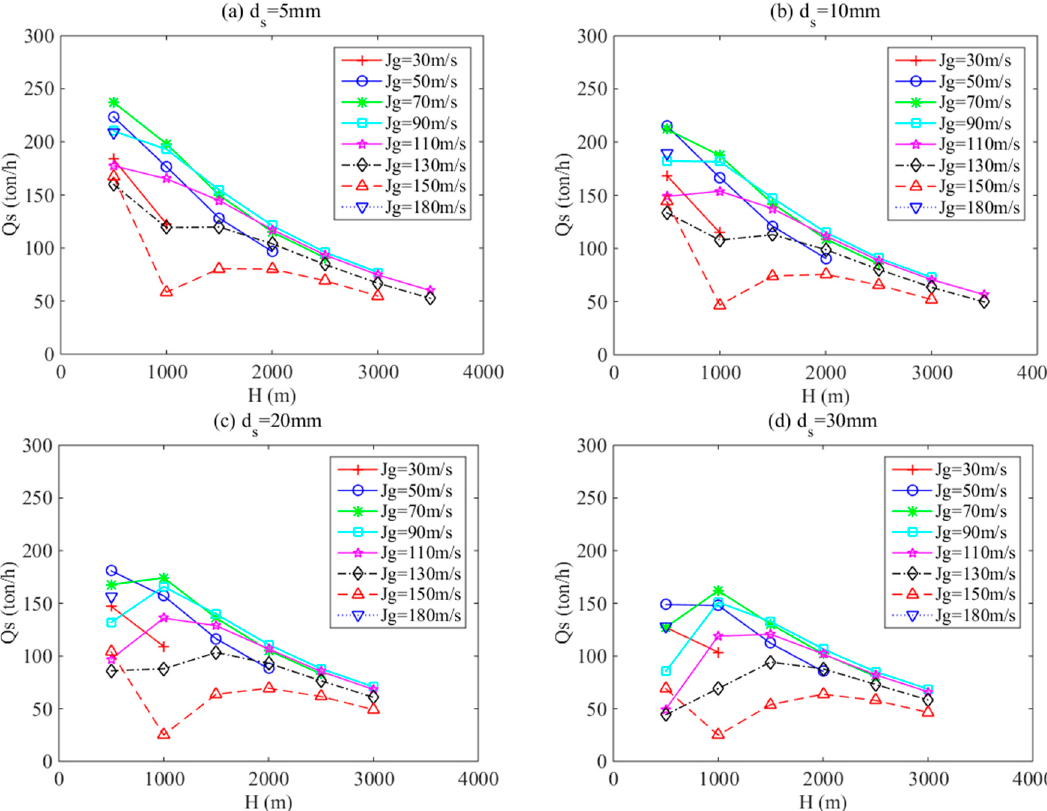
d at different mining s